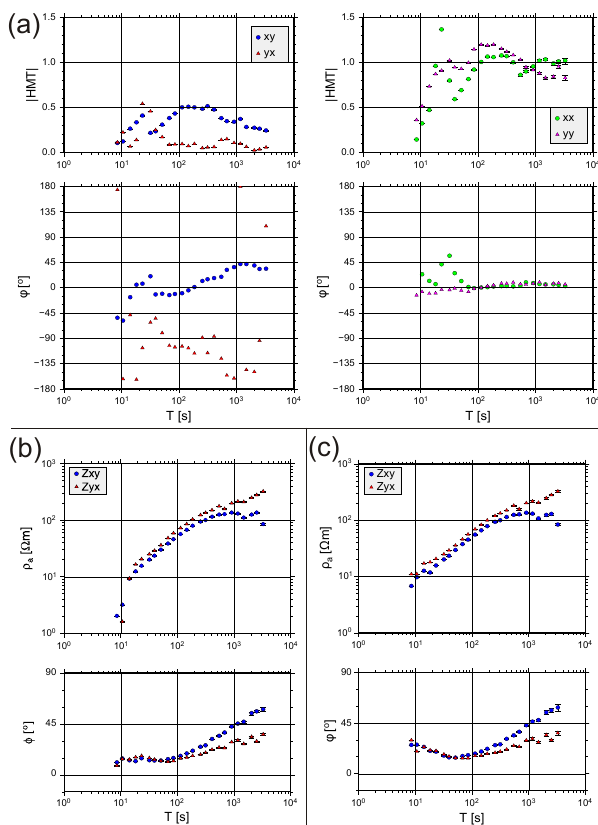
Figure 2. The inter-station transfer function between sites GRB and SUW (a) behaves erratically (from an induction point of view) for periods below 100s. Sounding curves for GRB from the same data (amount 5 days, (b) single-site, (c) remote-reference with SUW, only off-diagonal elements shown) in this period range do not show unusual features.